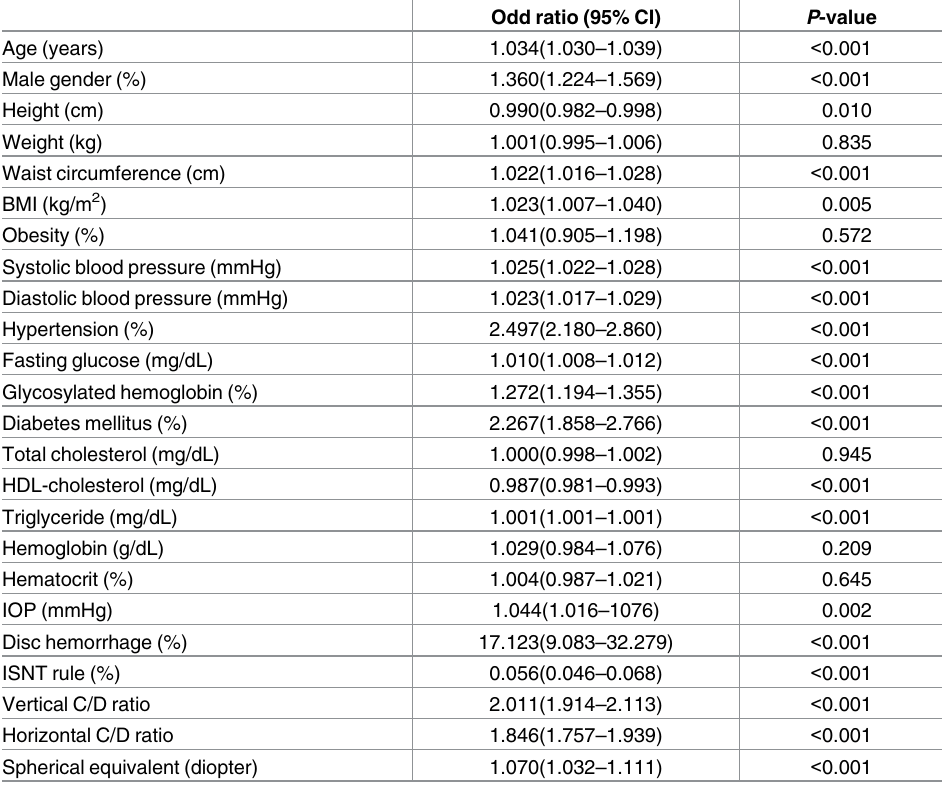
Table 4. Univariate regression analysis for systemicand ocular parameters in the retinal nerve fiber layer defect (RNFLD) group, using the non-RNFLD group as a